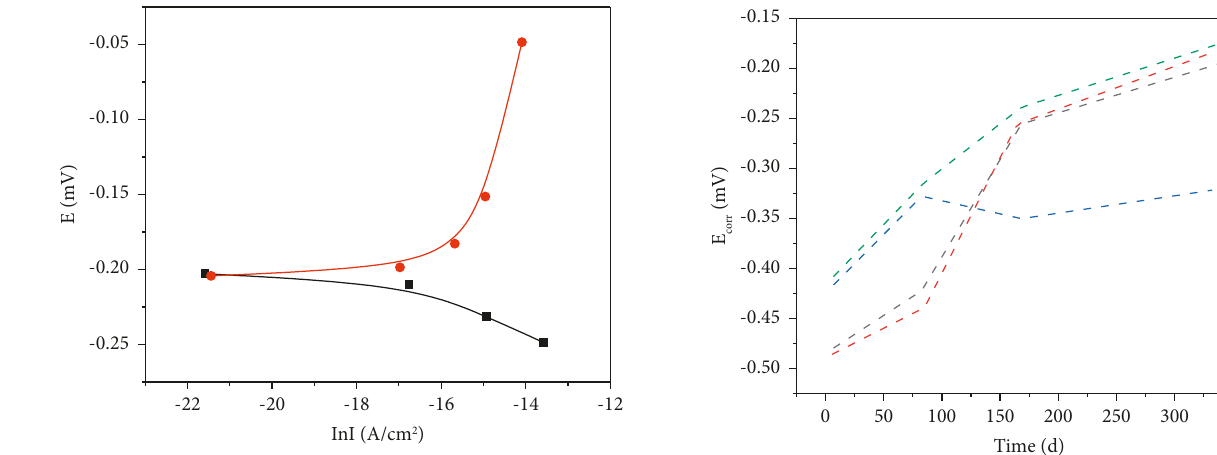
Figure 2: The rebar polarization curve of specimen L2 at 336